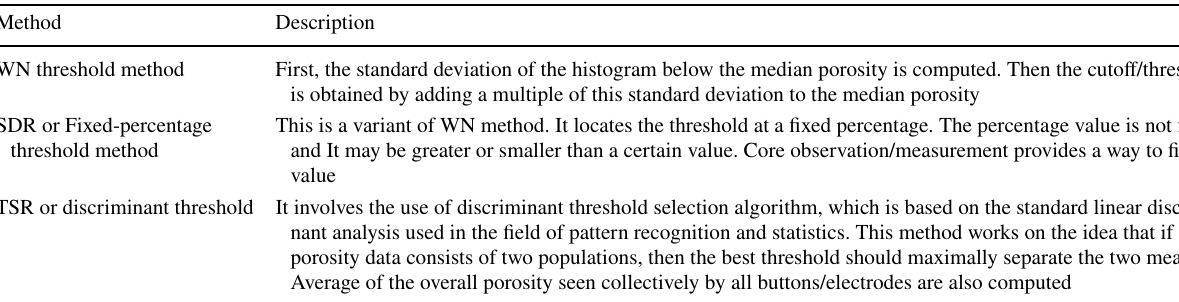
Table 1 Three applied methods for porosity